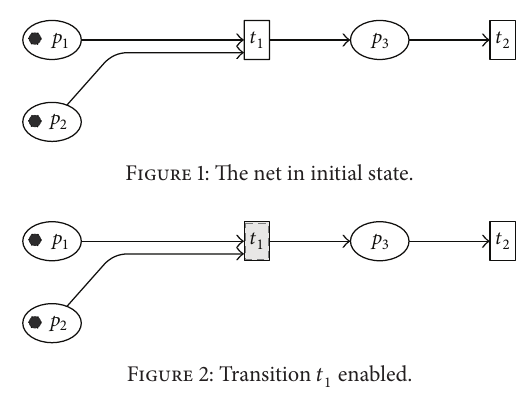
Figure 2: Transition 𝑡 1 enabled.